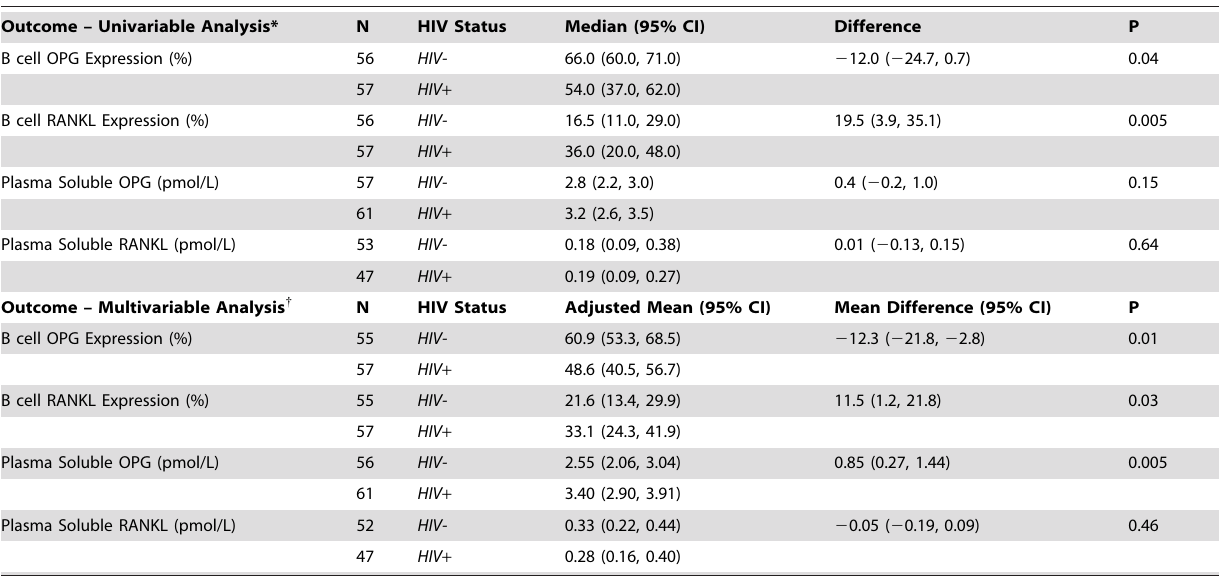
Outcome – Univariable